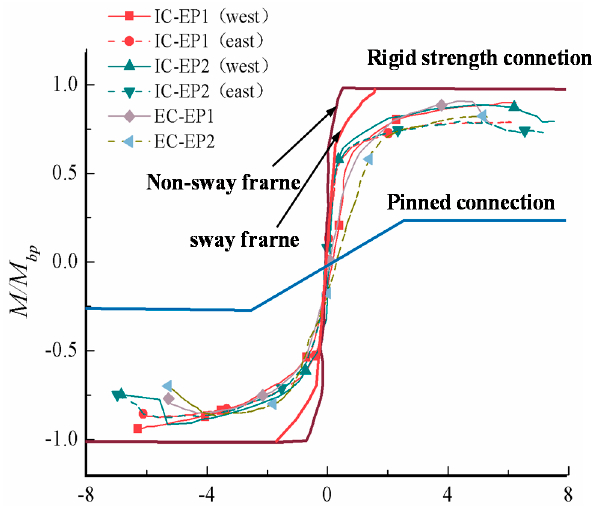
Figure 16. Classification of tested connections.